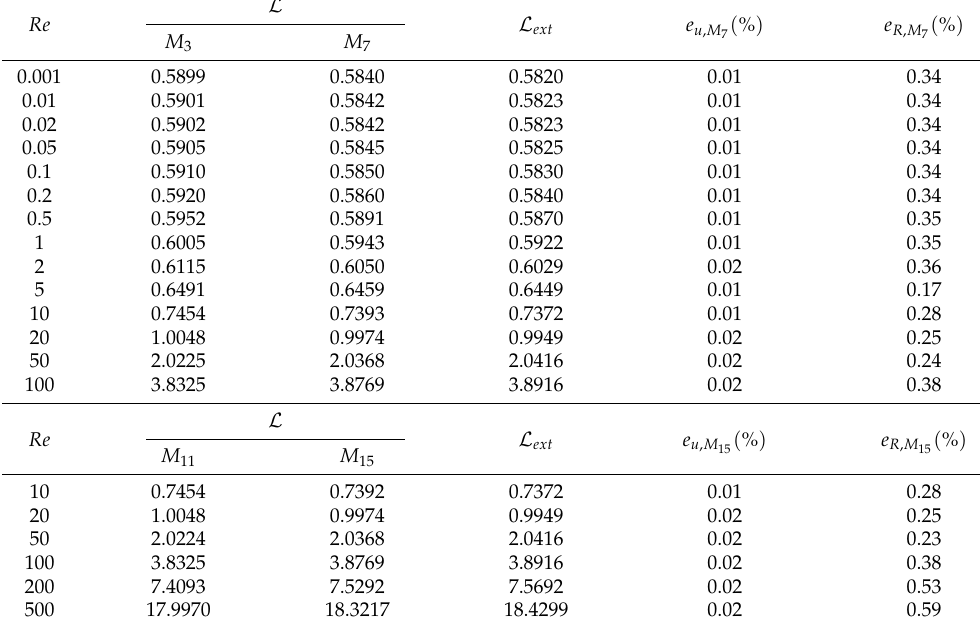
Table A3. Mesh accuracy tests and development lengths for AR =